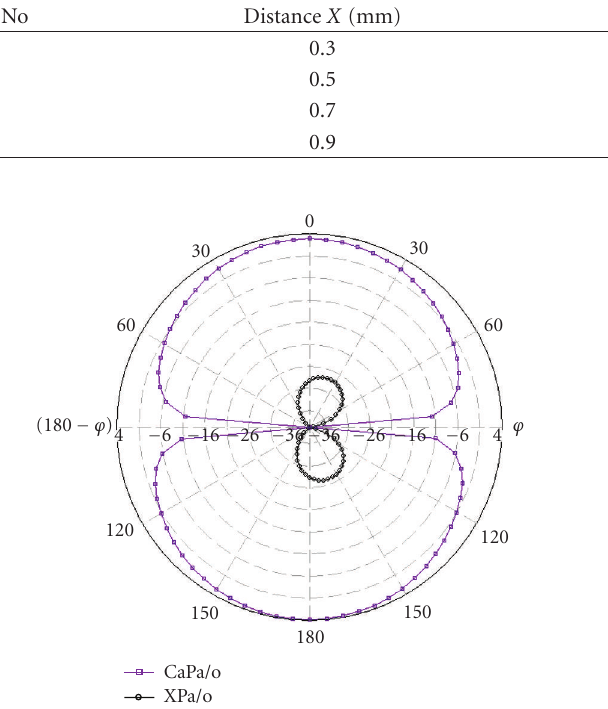
Figure 5: Gain versus frequency.